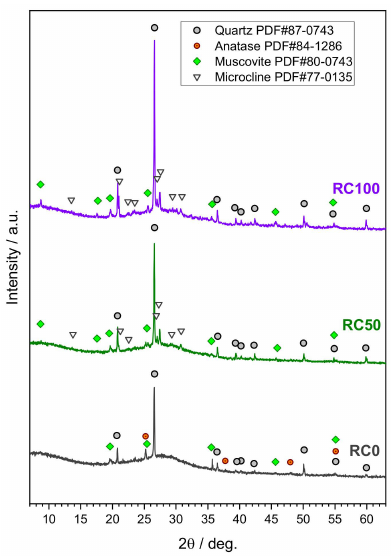
Figure 10. A comparison between the XRD patterns of the binders synthesized with progressive replacement (0, 50, and 100%) of metakaolin by local calcined clay after 28 days of curing.